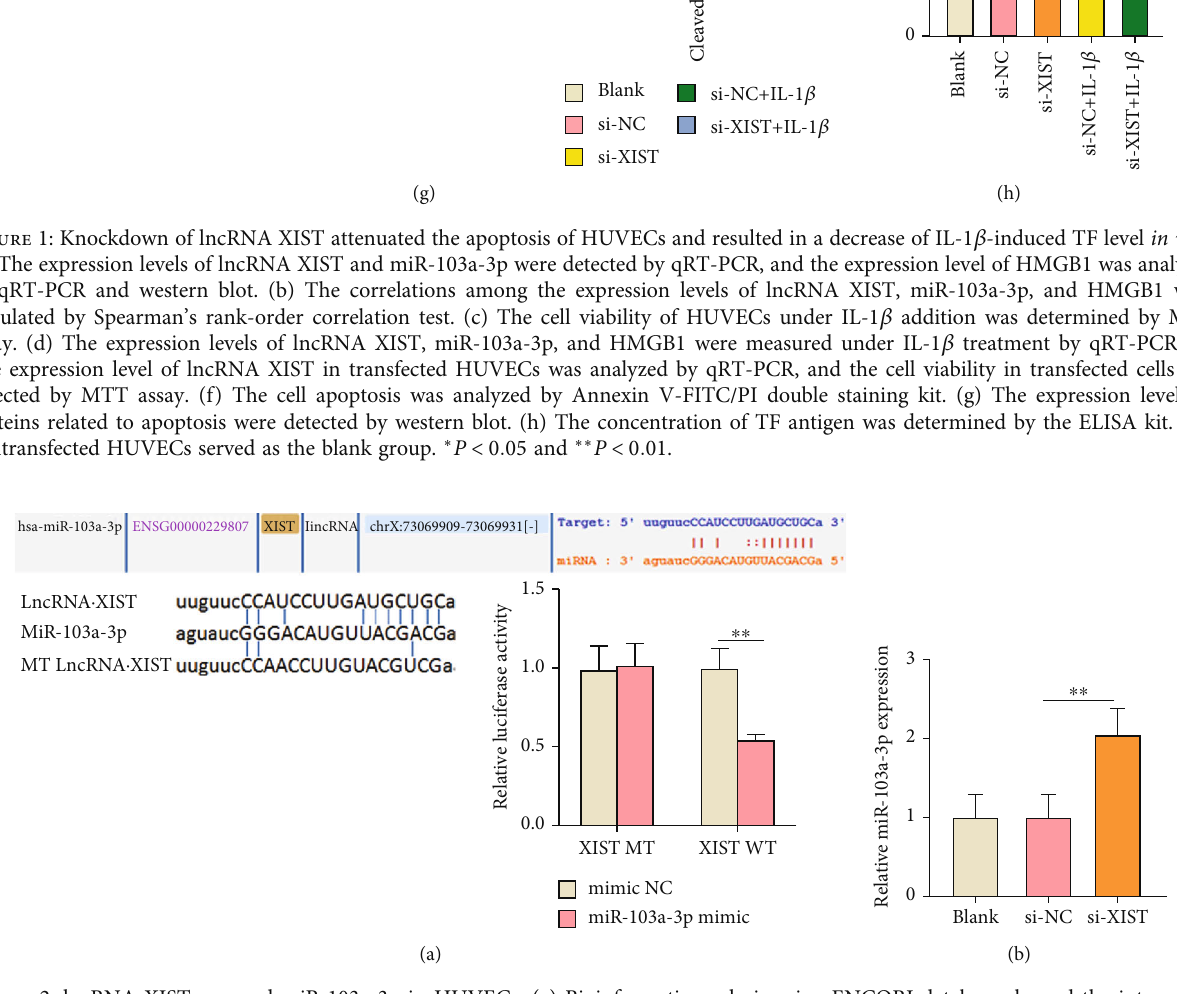
Figure 2: lncRNA XIST sponged miR-103a-3p in HUVECs. (a) Bioinformatic analysis using ENCORI database showed the interaction between lncRNA XIST with miR-103a-3p, and the binding relationship of lncRNA XIST and miR-103a-3p was veri fi ed by luciferase reporter gene assays. MT: mutant type; WT: wild type. (b) The expression of miR-103a-3p in transfected HUVECs was detected by qRT- PCR assays. ∗ P < 0 : 05 and ∗∗ P < 0 : 01